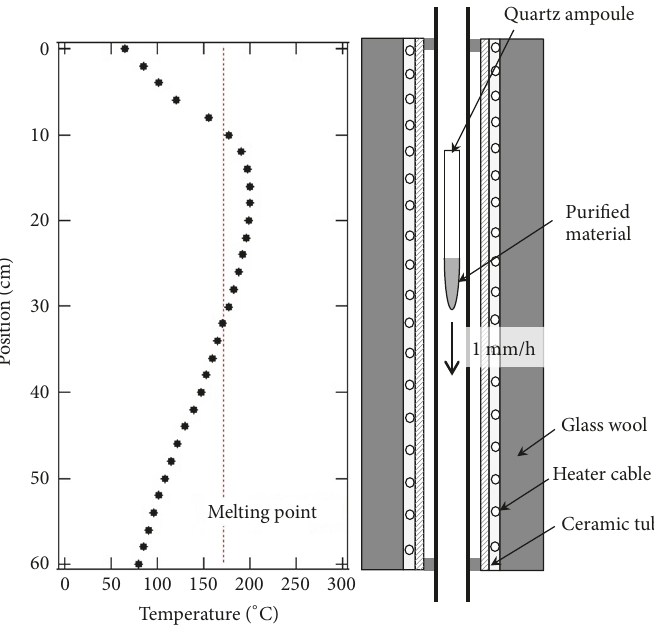
Figure 2: Schematic of a Bridgman furnace and the temperature distribution used in the present